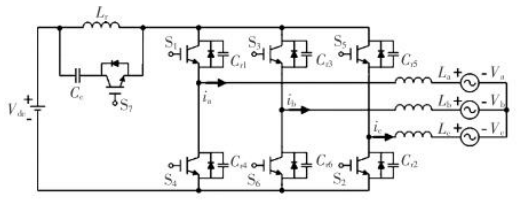
Fig. 1. Topology of ZVS inverter